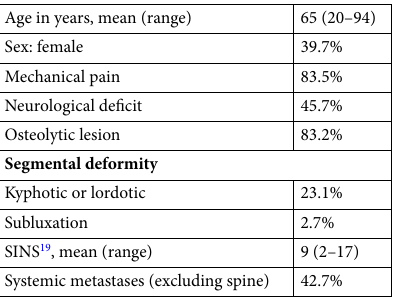
Table 1. Baseline and radiographic characteristics of cohort.